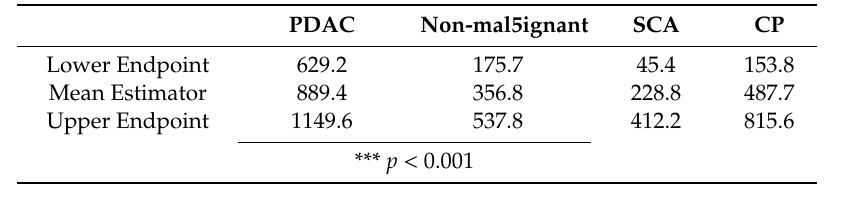
Table 4. Mean estimators and 95% confidence interval of the various entities using the primary antibody anti-PD-L1.